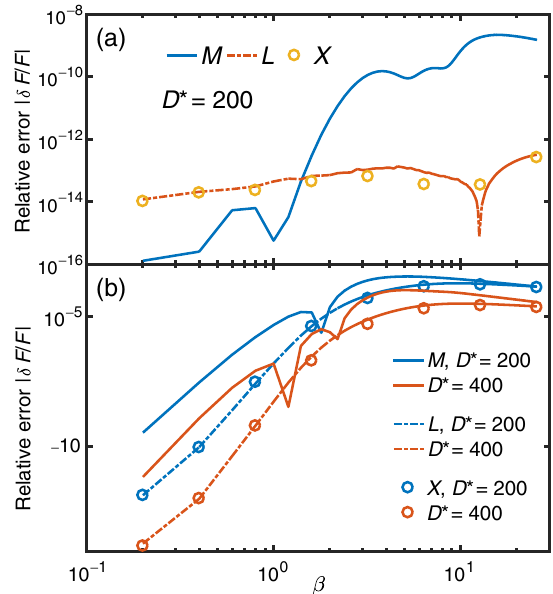
FIG. 18. Relative errors of the free energy fully within SETTN in (a) an L ¼ 16 Heisenberg chain and (b) a 4 × 4 Heisenberg model on the square lattice (OBC). The data is computed along various β grids, including Maclaurin ( M ) expansion around β ¼ 0 and Taylor expansion in linear ( L ) and exponential ( X ) β scales. In (a), we use D (cid:3) ¼ 200 , resulting in relative CPU run times M ∶ L ∶ X ¼ 2 . 34 ∶ 5 . 25 ∶ 1 . In (b), we use D (cid:3) ¼ 200 , 400. For D (cid:3) ¼ 200 , this results in relative CPU run times M ∶ L ∶ X ¼